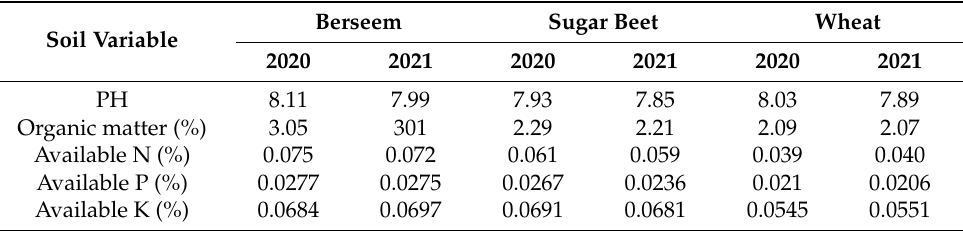
Table 2. Some physical and chemical properties of the soil of the experiment site after harvesting preceding